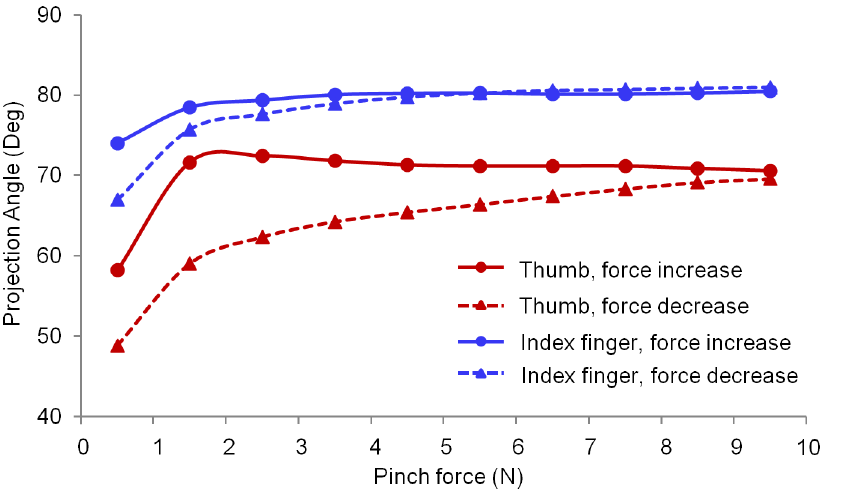
Figure 5. Force projection angles for the thumb and index finger. Each data point represents the average of PA for all trials within the specified 1-N force